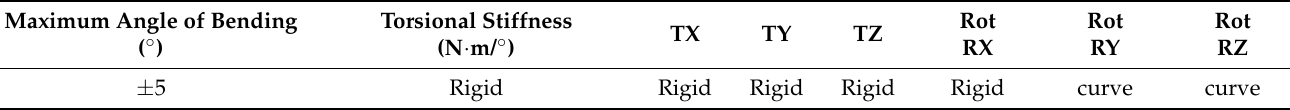
Table 1. Degrees of freedom of a ball joint in different directions.